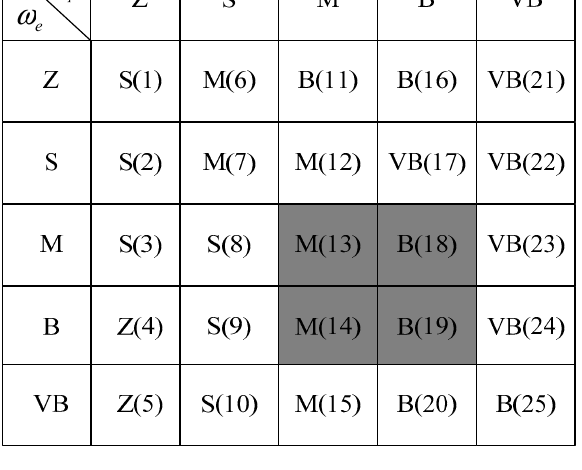
Figure 6. MTPA rule table.